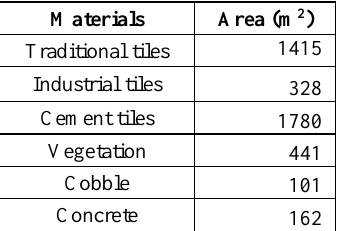
Table 7: Distribution of areas where there were previously zinc roofs